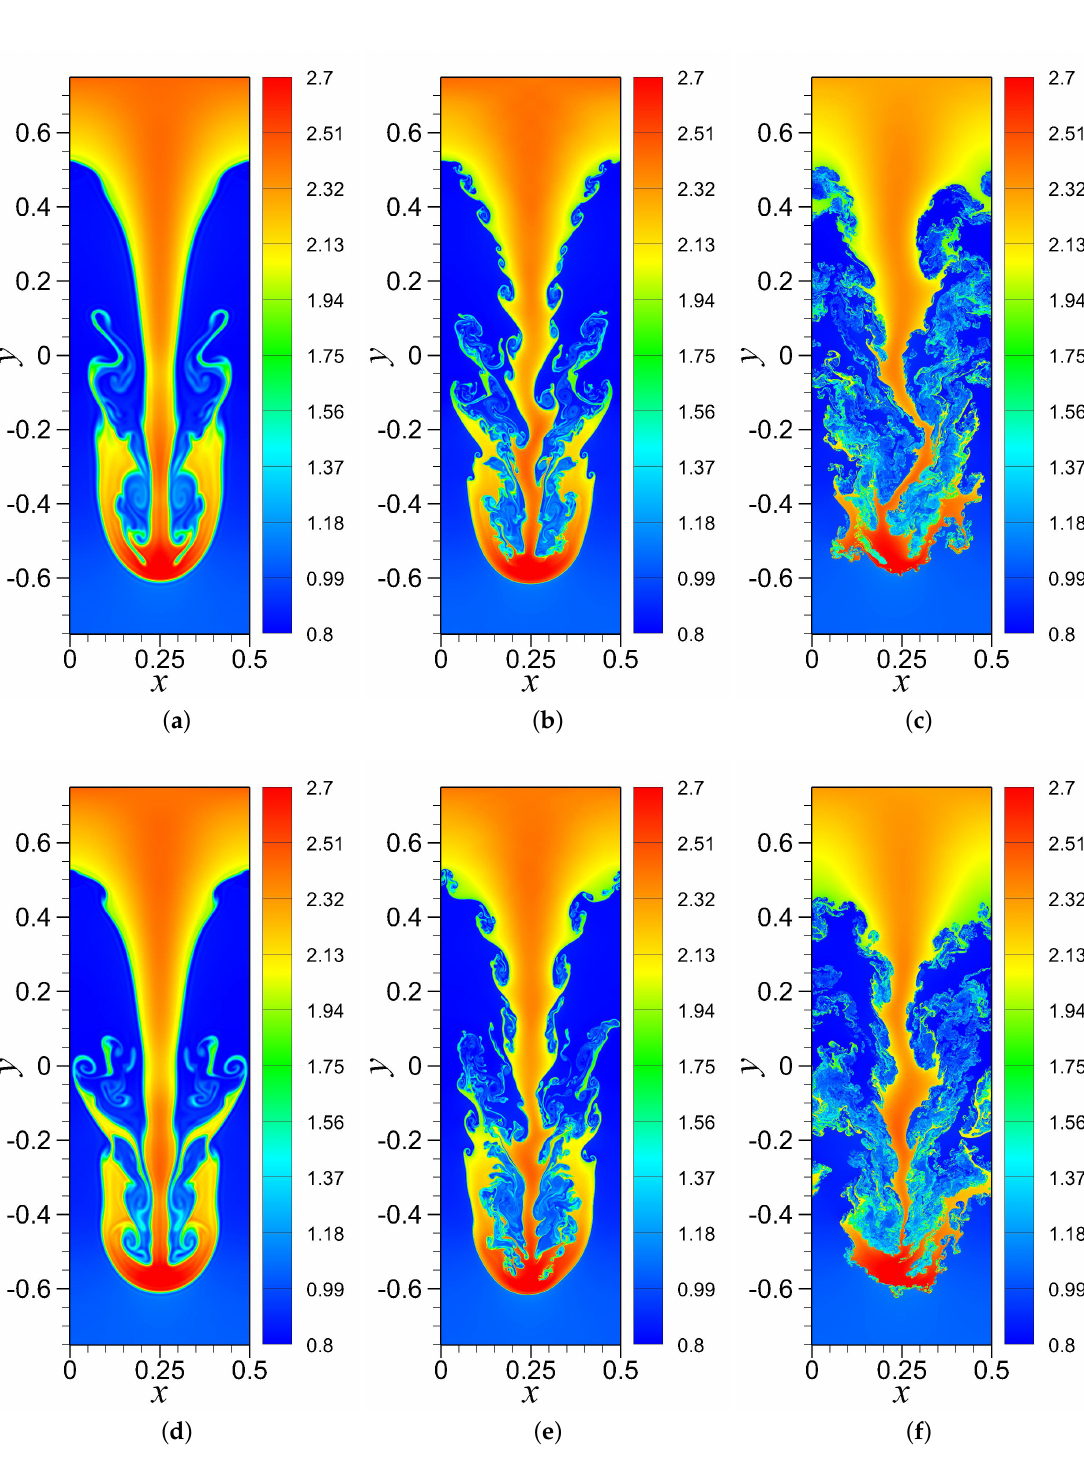
Figure 19. Density contours for the RTI problem with single-mode perturbation at t = 4.5 for different coarse grid resolutions and filtering strength, σ of CS+RF schemes: ( a ) σ = 1.0 with 256 × 768 resolution; ( b ) σ = 1.0 with 1024 × 3072 resolution; ( c ) σ = 1.0 with 4096 × 12288 resolution; ( d ) σ = 0.4 with 256 × 768 resolution; ( e ) σ = 0.4 with 1024 × 3072 resolution; ( f ) σ = 0.4 with 4096 × 12288 resolution. The gravity is directed in a vertically downward